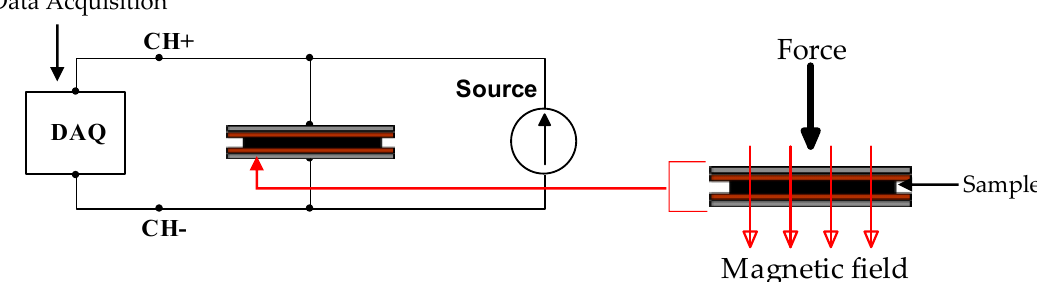
Figure 1. Circuit schematic for resistivity testing ( left ) and fabricated test rig ( right ). DAQ acts as a data logger.